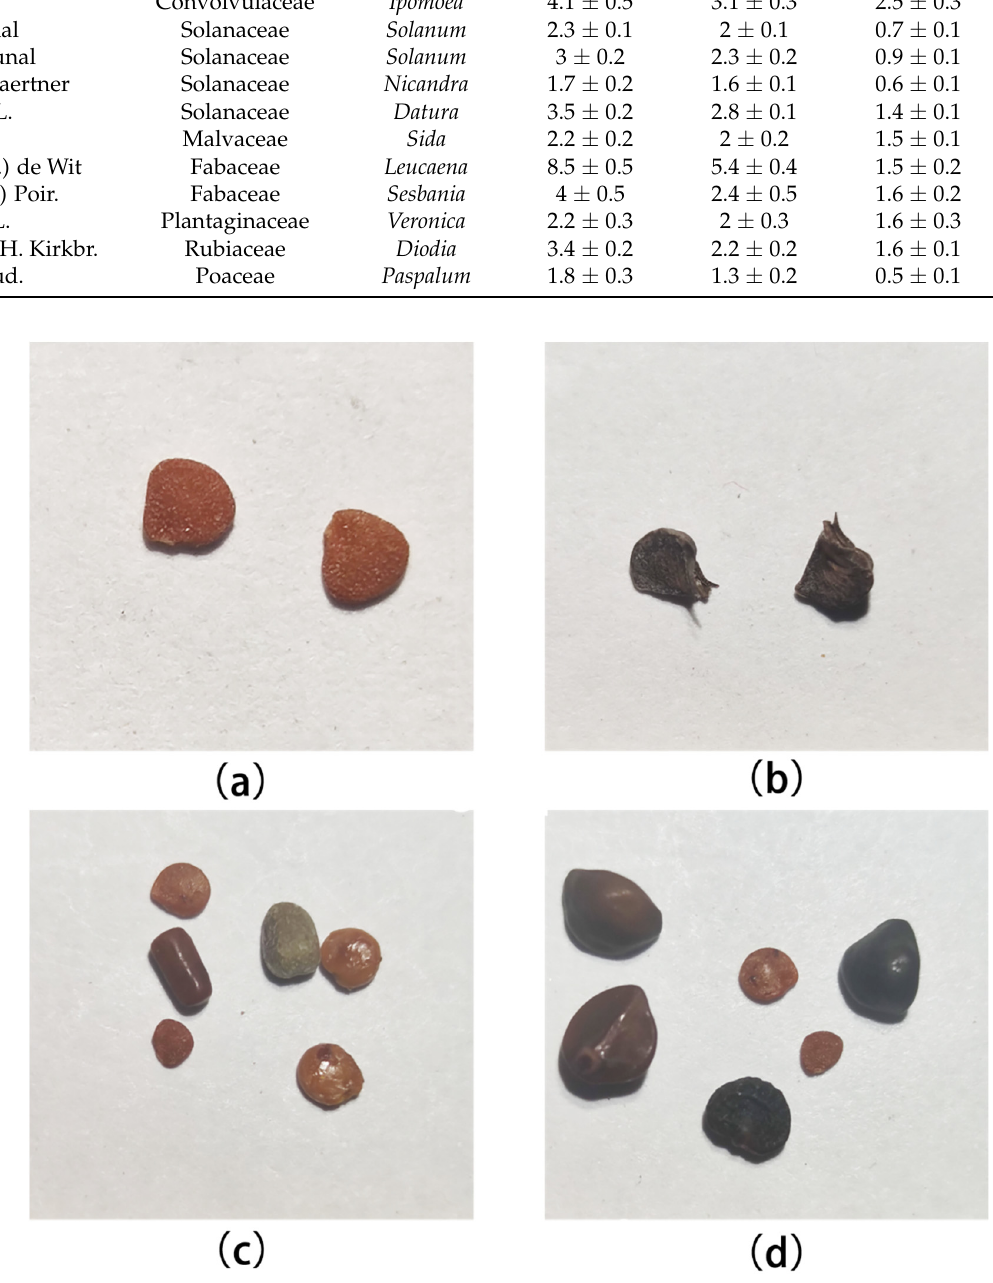
Figure 12. Partial data set display: ( a , b ) single species images in data set; ( c , d ) mixed species images in data set.